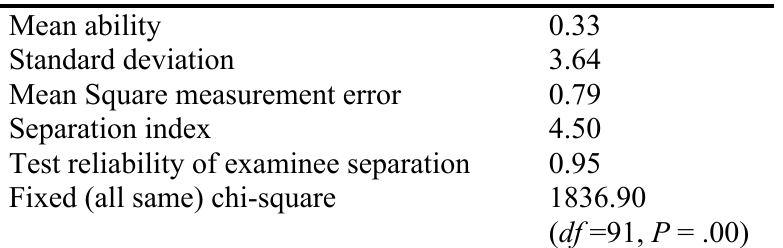
Summary of Statistics on Examinees